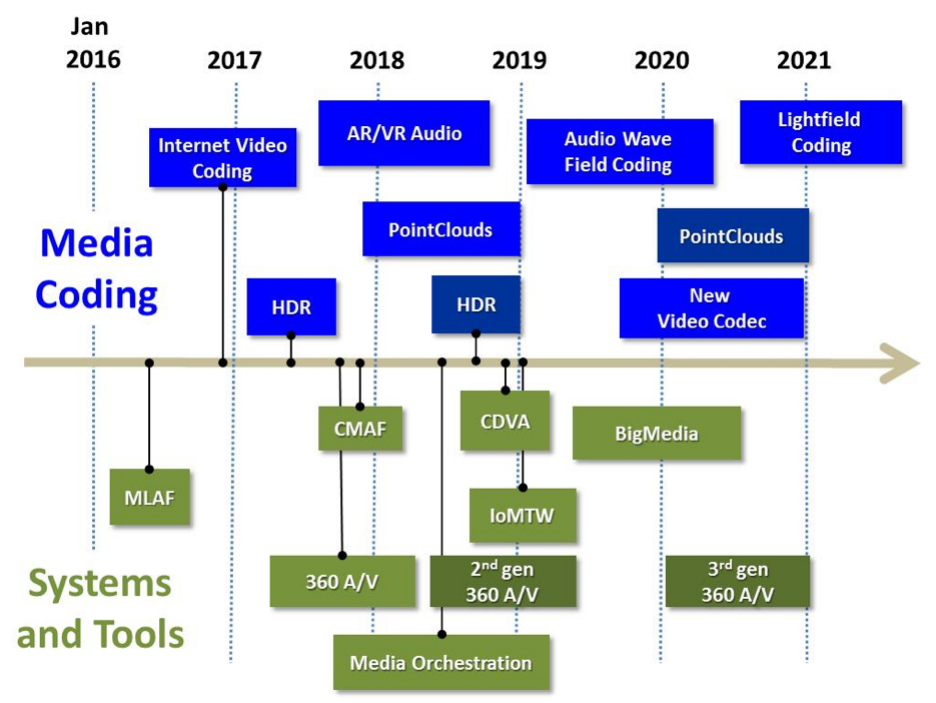
Figure 1. Moving Picture Experts Group (MPEG) standardization